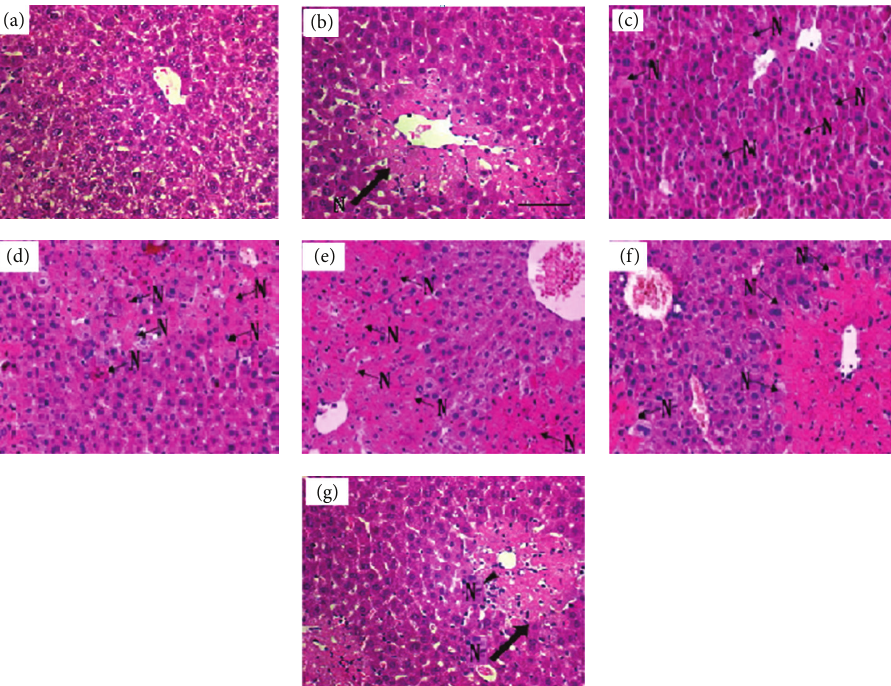
Figure 1: Histologic results of liver tissues stained with hematoxylin and eosin under light microscope in CCl 4 -treated rats ( × 200). (a) control; (b)–(g) 12, 36, 70, 96, 110, and 125 h after exposure to CCl 4 , respectively. N: